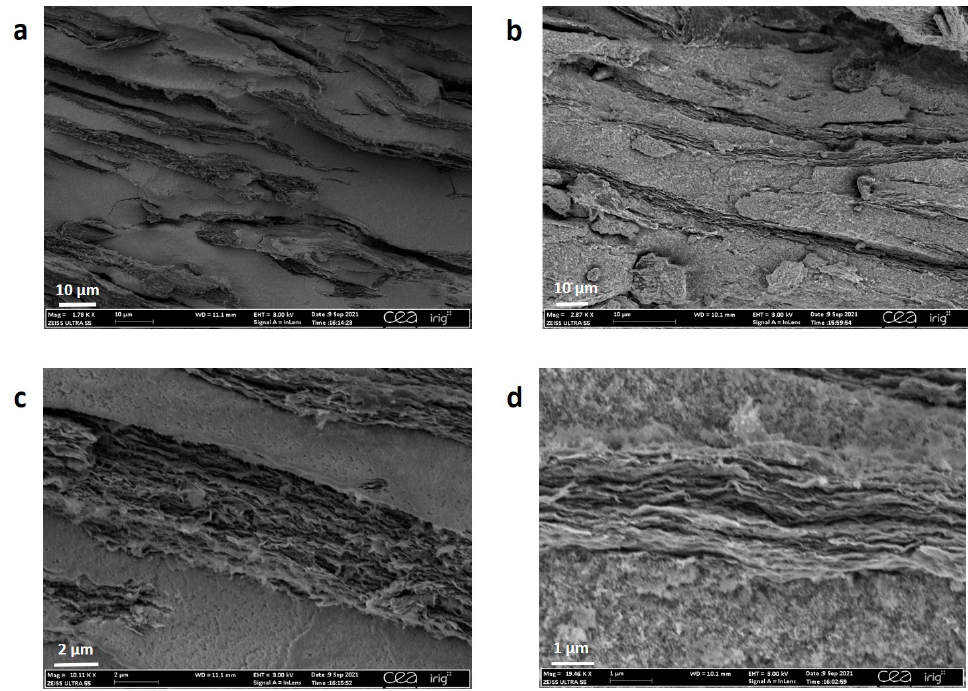
Figure 9. SEM images at different magnifications of ( a , c ) Si-GHG and ( b , d ) Si@C-GHG samples were obtained by a simple mixture of components.